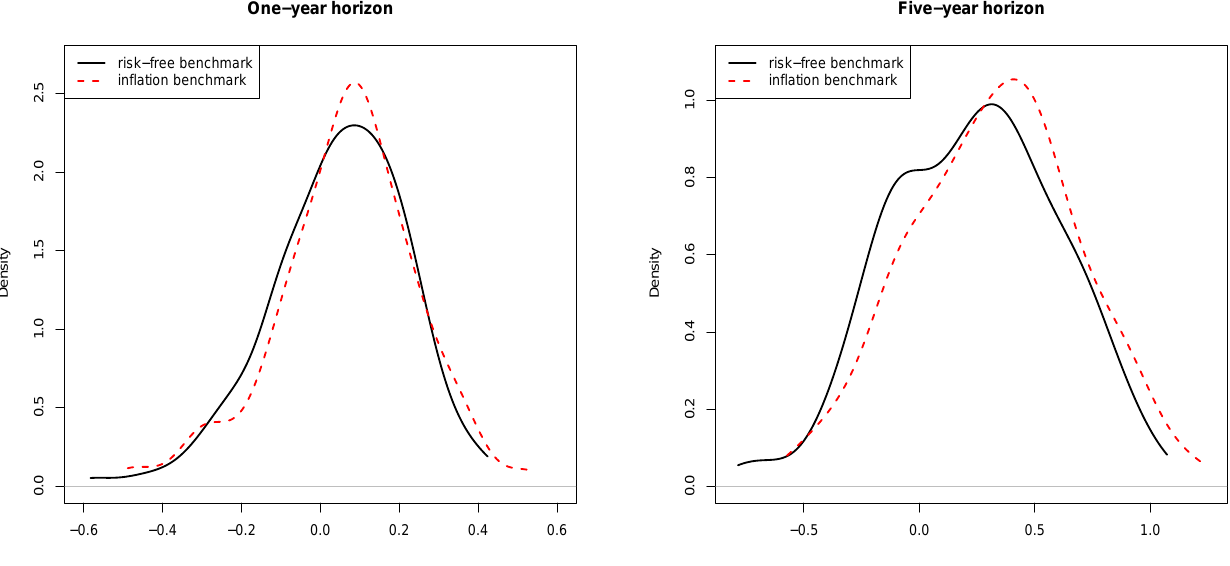
However, the returns transformed with the two benchmarks differ only slightly. A small upward shift under the inflation benchmark is noticeable in Figure 1, which shows density plots of the benchmarked returns for both the one- and five-year horizons.